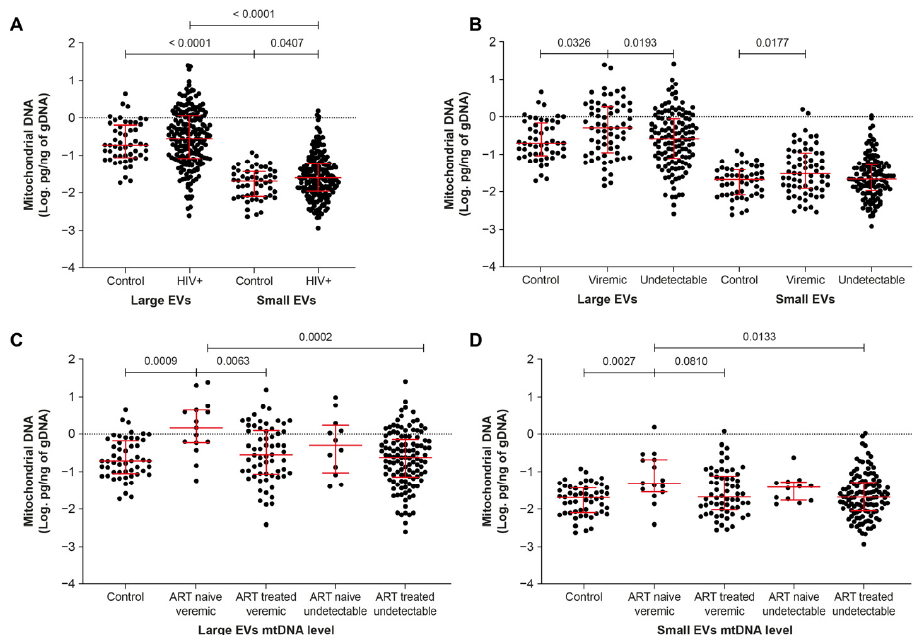
Figure 1. Mitochondrial DNA content of large and small EVs in viremic and non-viremic partici- pants. ( A ) HIV-infected versus uninfected participants; ( B ) in viremic and non-viremic participants irrespective of antiretroviral therapy (ART); ( C , D ) in viremic and non-viremic participants on ART or not. In graphs, the dots represent individual value and lines the geometric mean with geometric standard deviation factor. Groups were compared using t -tests and ordinary one-way ANOVA with Tukey’s multiple comparisons test.